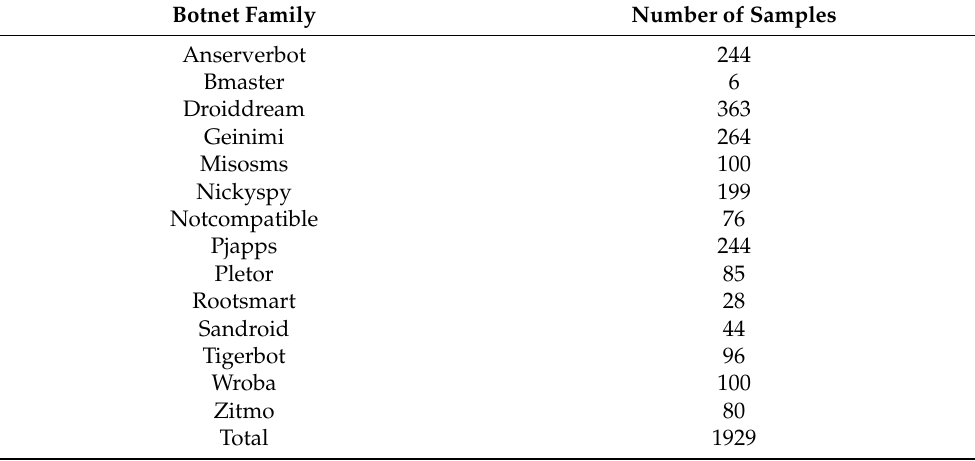
Table 3. Botnet dataset